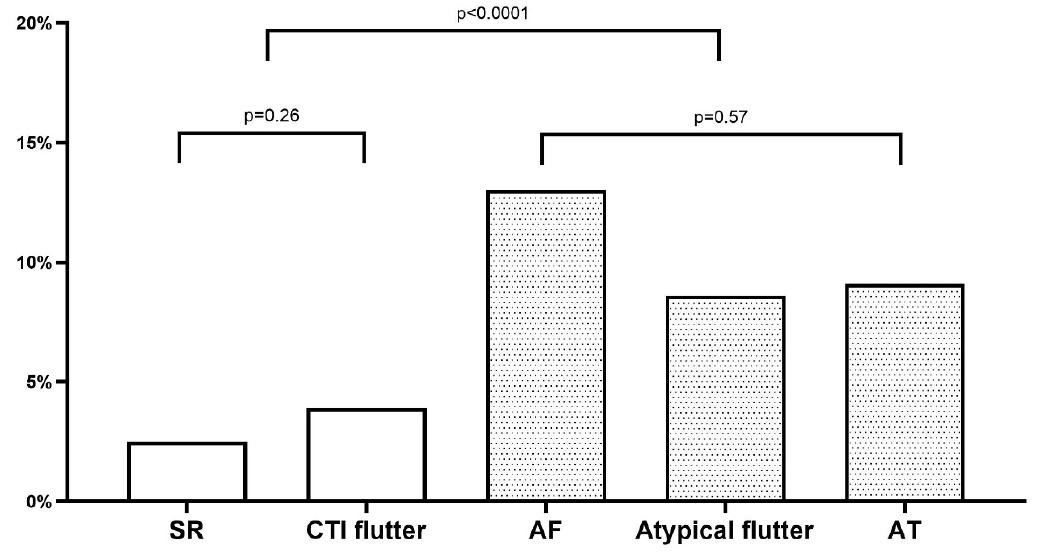
Figure 2. Proportion of patients with either a LAA thrombus or significantly reduced LAA emptying velocity stratified by underlying rhythm. AF = atrial fibrillation, AT = atrial tachycardia, CTI = cavotricuspid isthmus, SR = sinus rhythm.